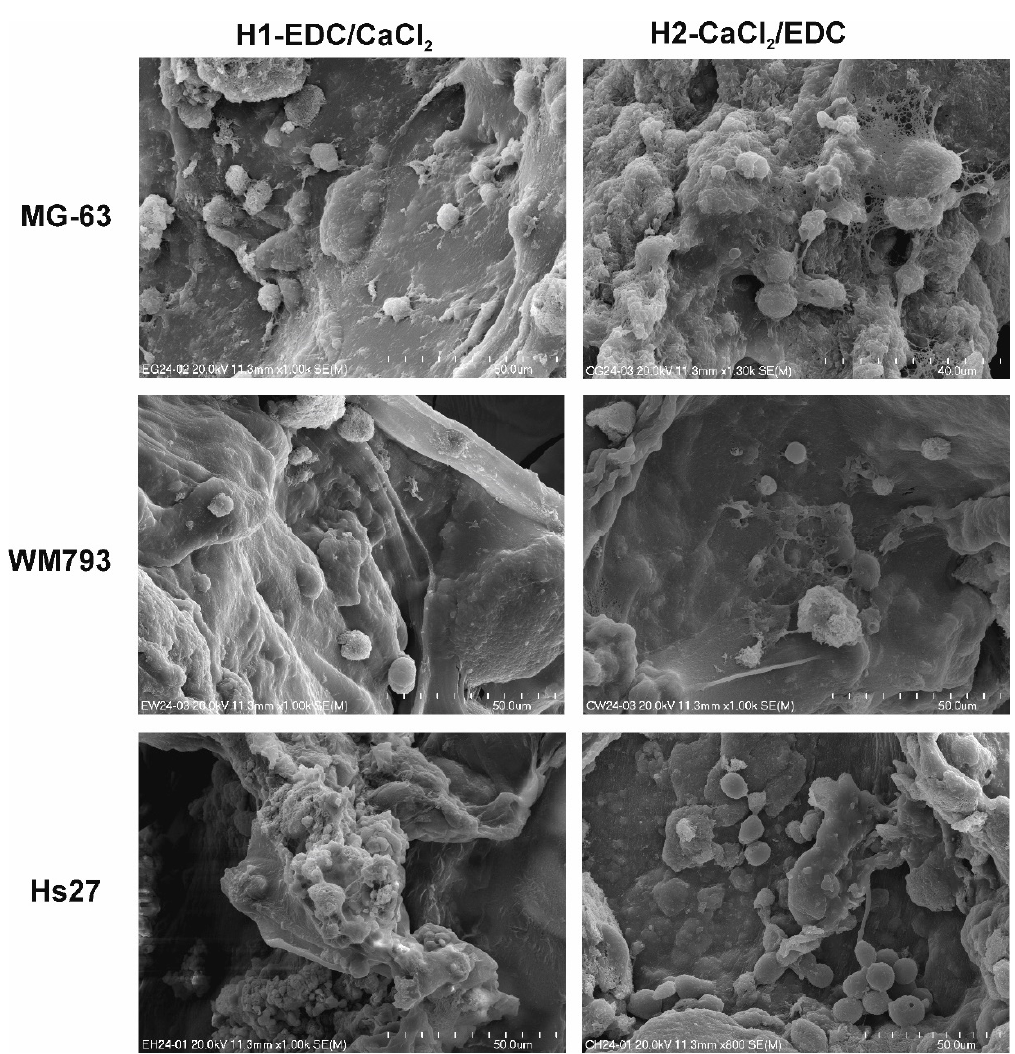
Figure 12. SEM images of the MG-63, HS-27 and WM-973 cell lines cultured on the H1-EDC/CaCl 2 and H2-CaCl 2 /EDC hydrogels for 24 h.